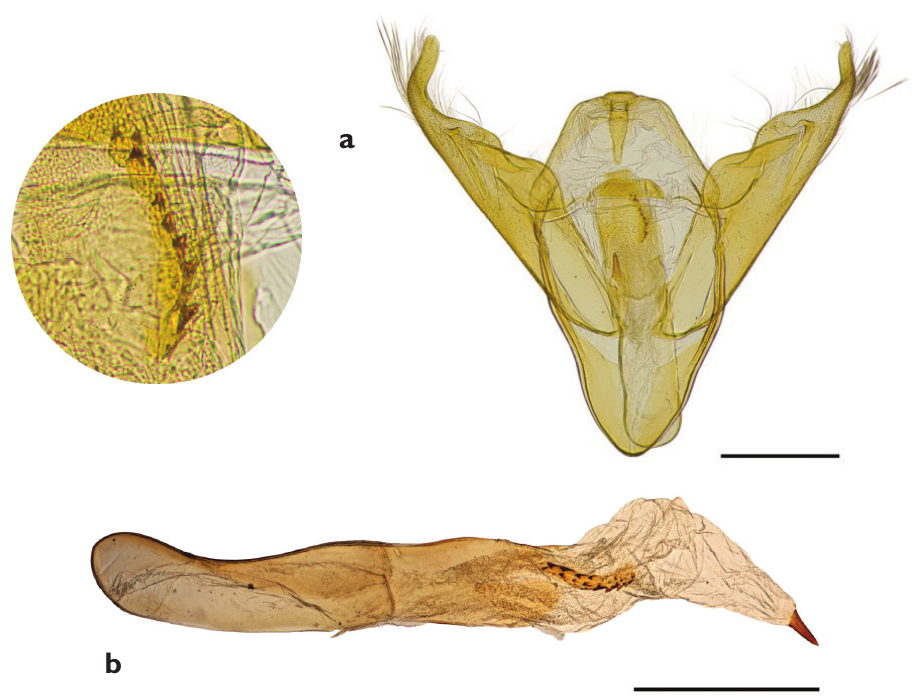
Figure 21. Genitalia of Abagrotis crumbi (= nefascia ). a Holotype, ♂ . USNM dissection #36819 b Para- type, ♂ . USNM dissection #36821. Scale bars: 1